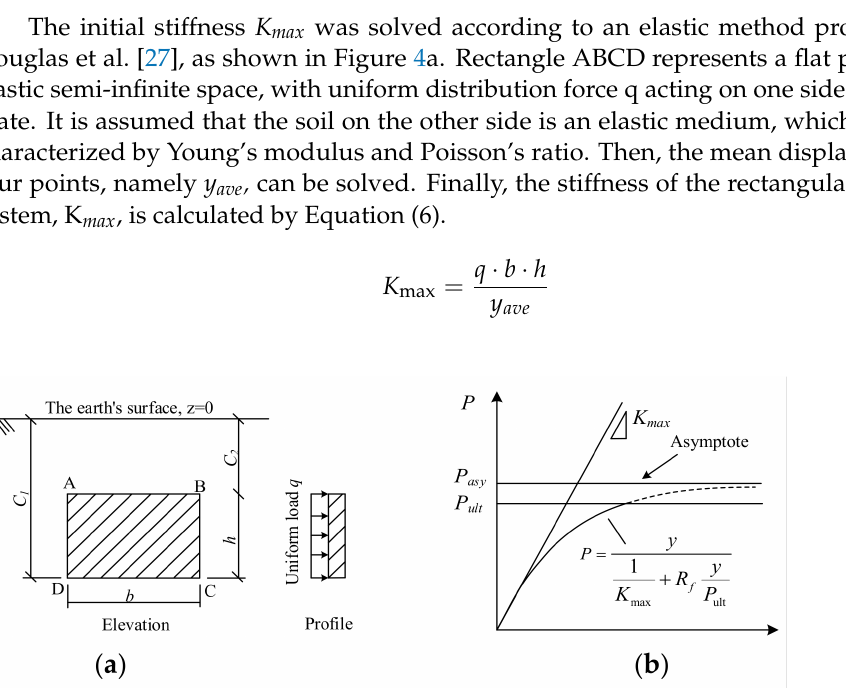
Figure 4. Abutment–backfill interaction modeling: ( a ) schematic diagram of the calculation of K max ; ( b ) force–displacement